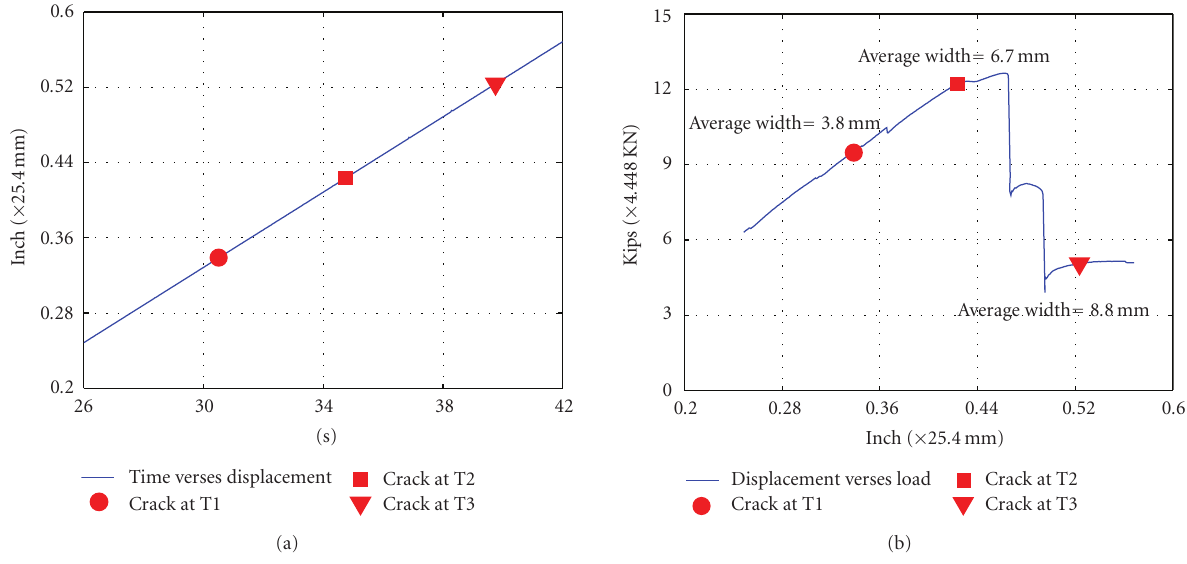
Figure 16: (a) Displacements versus time at mid-span; (b) measured load amplitude versus displacement at the mid-span, and the extracted average crack widths at T 1, T 2, and T